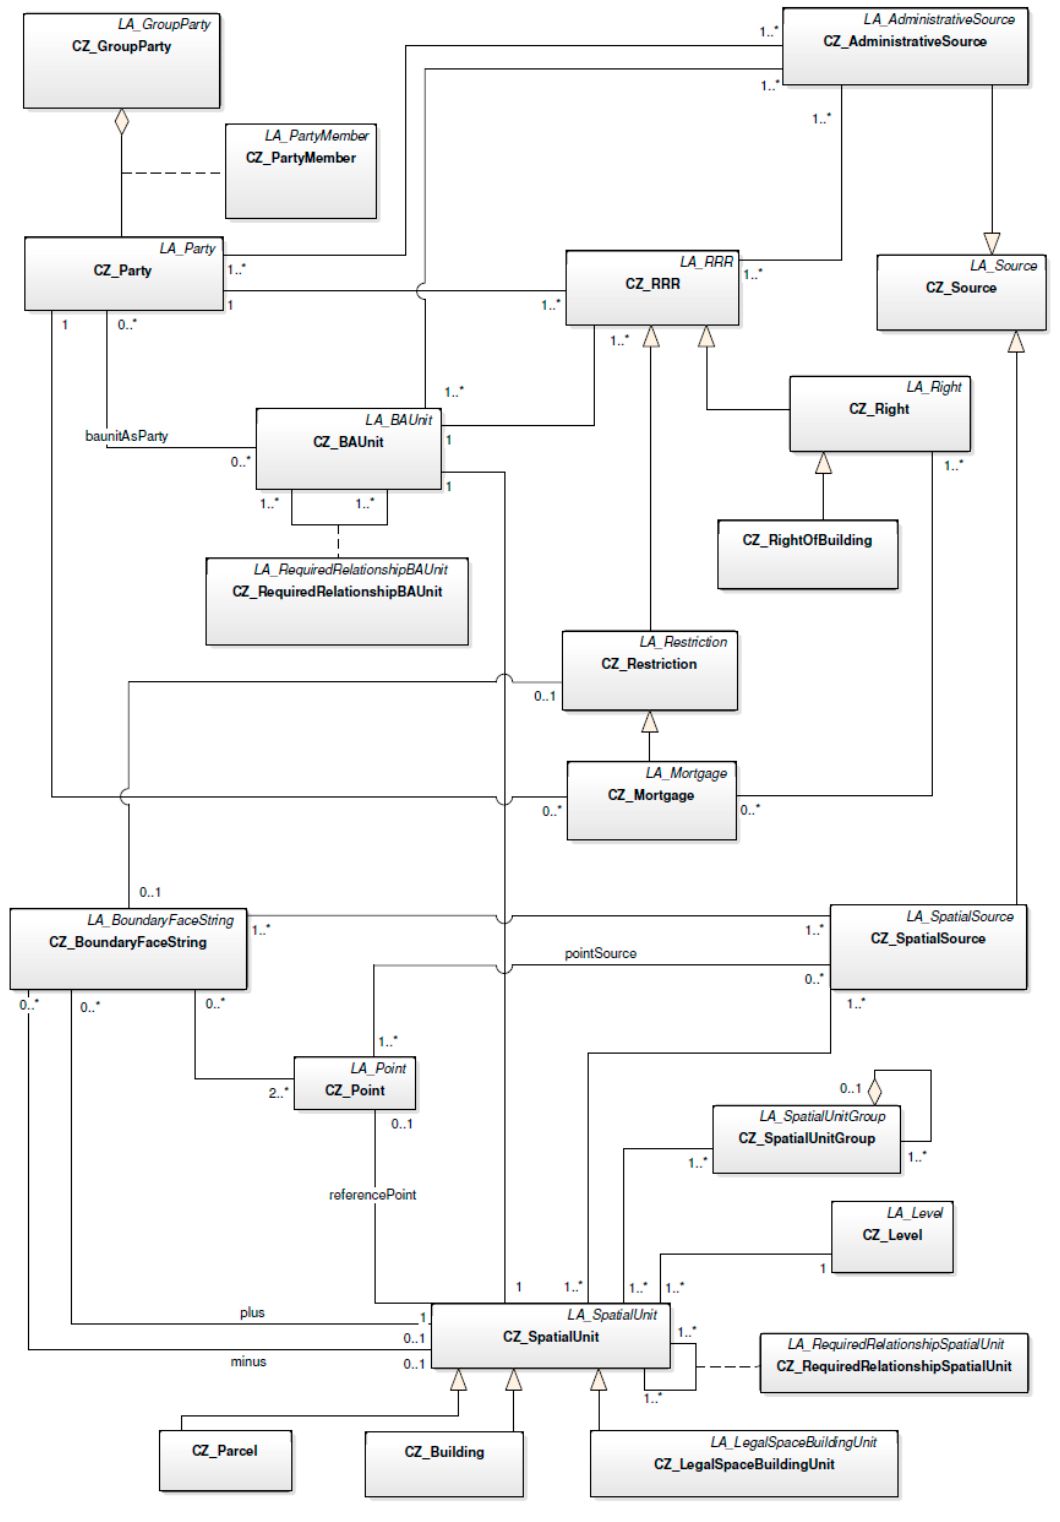
Figure 10. The Czech LADM-based country profile. Due to the complexity of the model, only the names of classes are mentioned here. The classes with their attributes are illustrated in Figure 8 (legal component) and Figure 9 (spatial